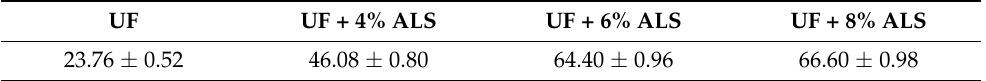
Table 2. Average dynamic viscosity values (mPa.s) of adhesive formulations used in this